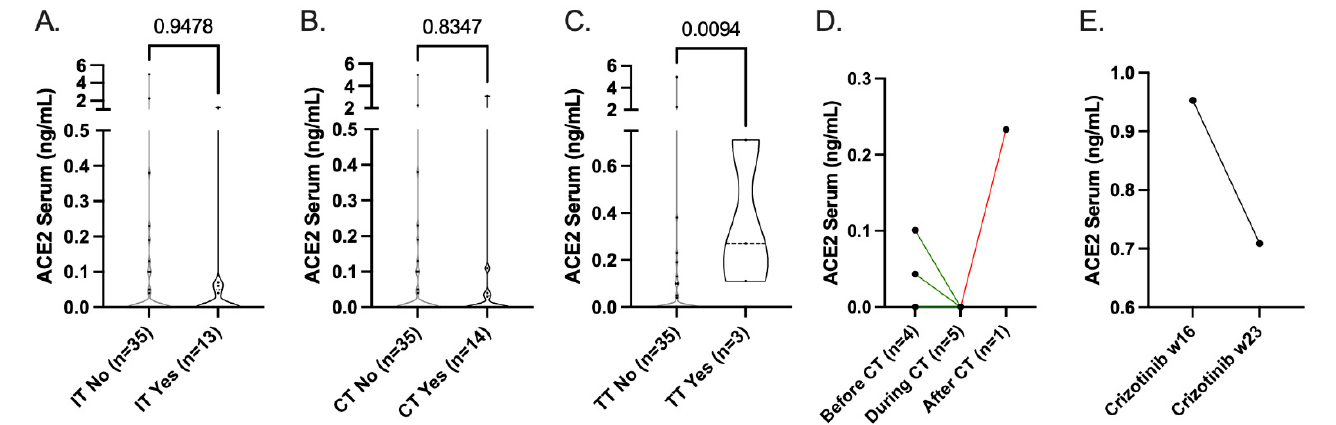
Figure 5. sACE2 levels related to systemic therapy. sACE2 levels in NSCLC adeno- and squamous- cell carcinoma, SCLC and malignant pleural mesothelioma lung cancer patients grouped by ( A ) immunotherapy ( n = 13; Atezolizumab, Nivolumab, Pembroluzimab), ( B ) chemotherapy ( n = 14; Carboplatin/Pemetrexed, Cisplatin/Pemetrexed, Carboplatin/Etoposide, Docetaxel), and ( C ) tar- geted therapy ( n = 3; Osimertinib, Crizotinib). sACE2 levels of paired patient samples during differ- ent stages of ( D ) chemotherapy or ( E ) Crizotinib treatment. Differences in expression levels were